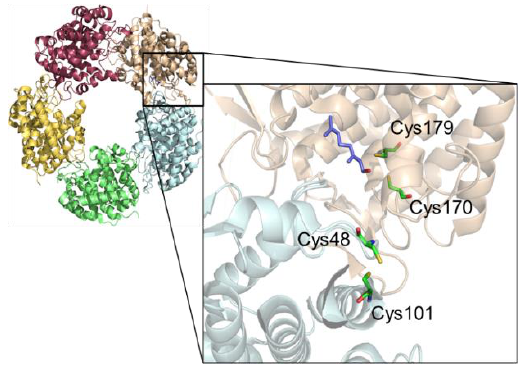
Figure 1. Overall structure and a close-up view of the active site of Ldi (PDB code: 5G1U [6]). Bound geraniol (purple) and the essential cysteines are highlighted in sticks. Cysteines 48 and 101 form a disulfide bond that caps o ff the active-site cavity. Reduced cysteines 170 and 179 in close vicinity to a monoterpenoid substrate participate in the catalytic